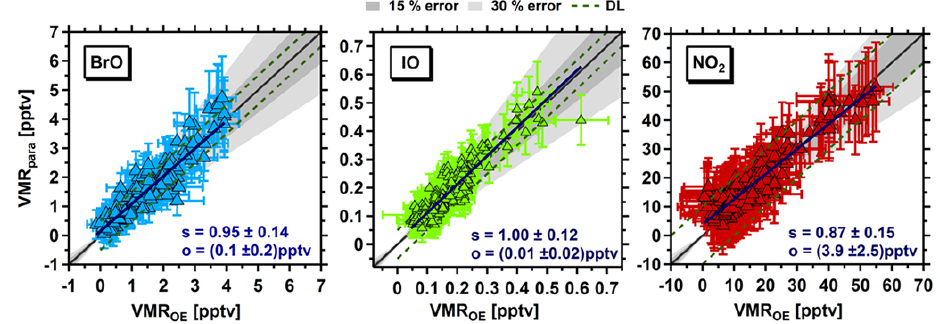
Figure 8. Correlations of TORERO AMAX-DOAS VMR data retrieved by parameterization (para) and optimal estimation (OE) for BrO (left), IO (middle) and NO 2 (right). Grey shaded areas indicate 15 and 30% error; green dashed lines show trace gas detection limits. Linear fits and fit parameter (s: slope; o: offset) are included in each panel.